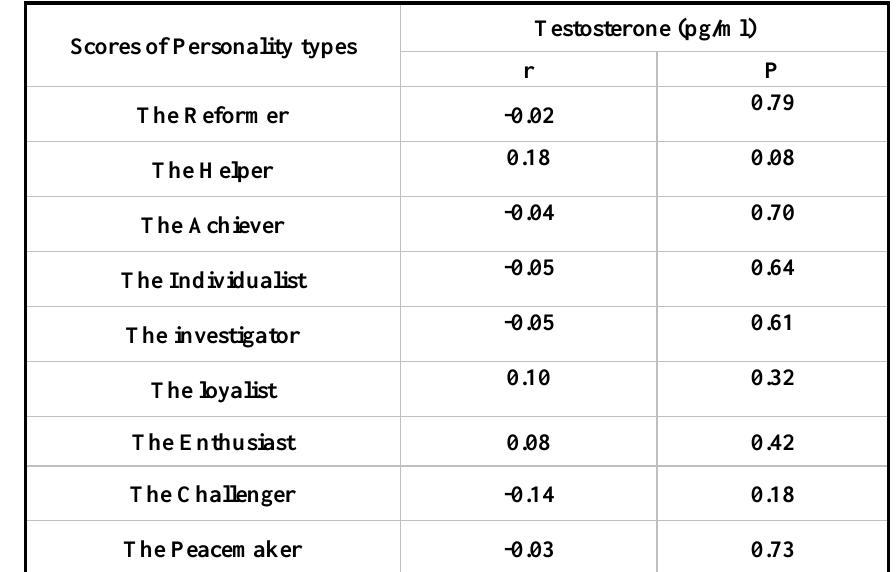
Table (3): Correlation Coefficient between salivary Testosterone concentrations (pg/ml) and the scores of the Nine Personality